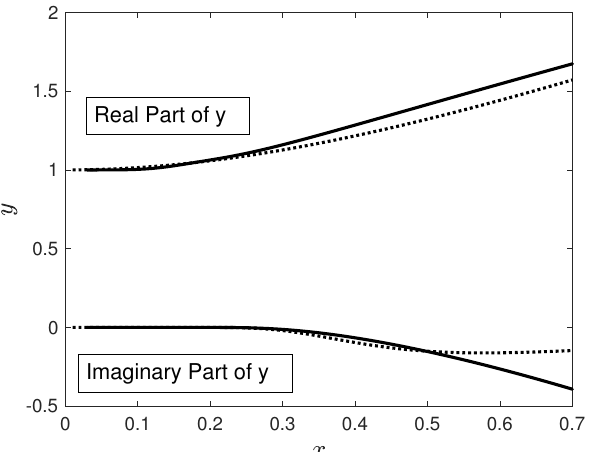
Figure 2. Visualized is the numerical solution of Equation (60). Shown are the real part of y = ω / ω p (top two lines) as well as its imaginary part (bottom two lines) versus the variable x = λ D k . Compared are the numerical solution (solid lines) with the analytical limits (dotted lines) given by Equations (82) and (91), respectively. ω p is the plasma frequency and λ D is the Debye